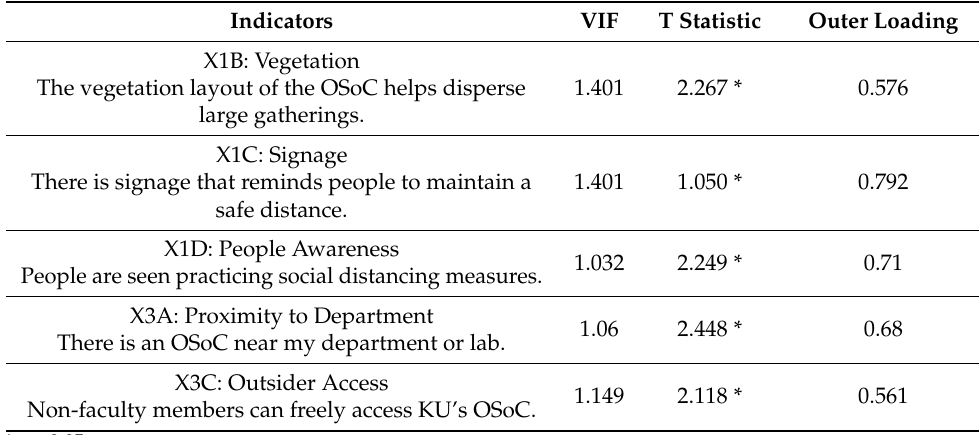
Table 2. Measurement Model Evaluation: Formative